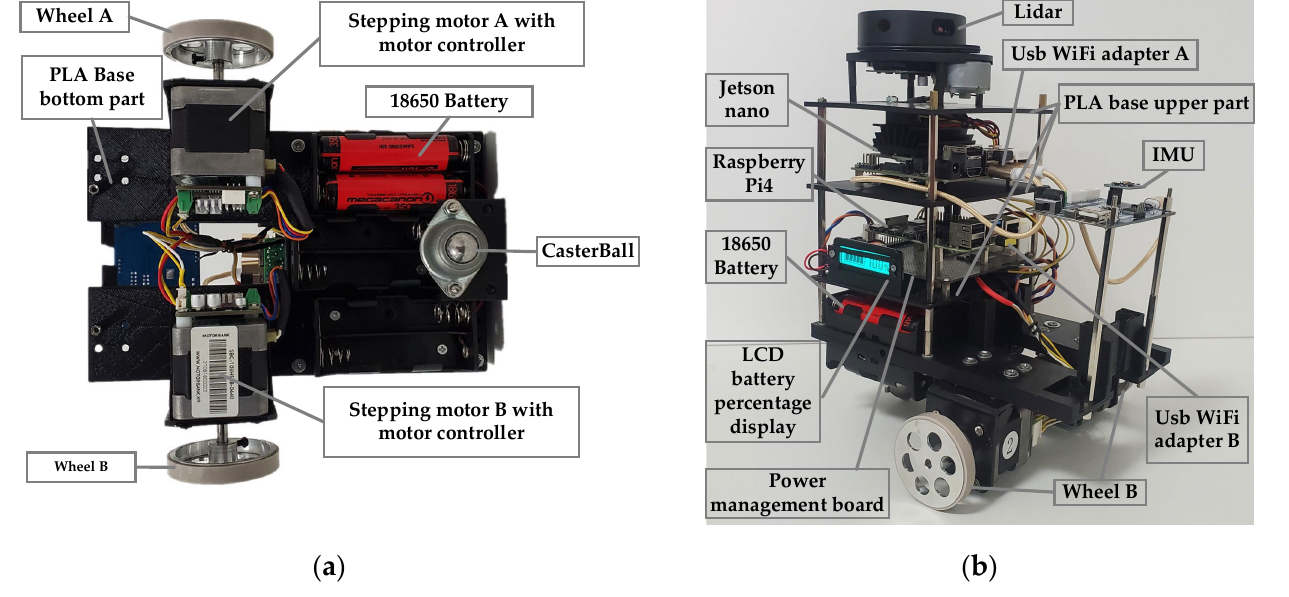
Figure 1. Owlbot robot and its components. ( a ) Bottom view; ( b ) Side view.